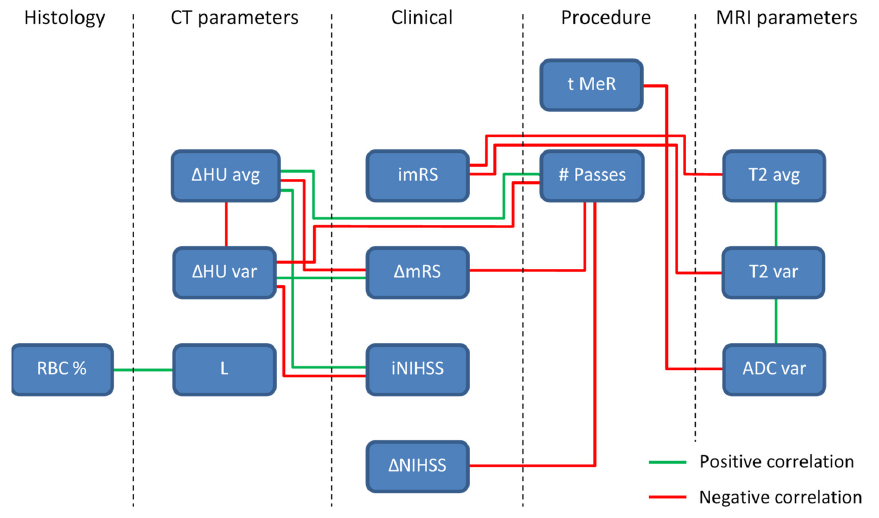
Figure 5. A diagram of significant correlations among different thrombi parameters. The parameters are organized according to their category in histology, CT, clinical, procedure and MRI parameter groups and existing correlations between parameter pairs are plotted with a green line for positive correlations and a red line for negative correlations.